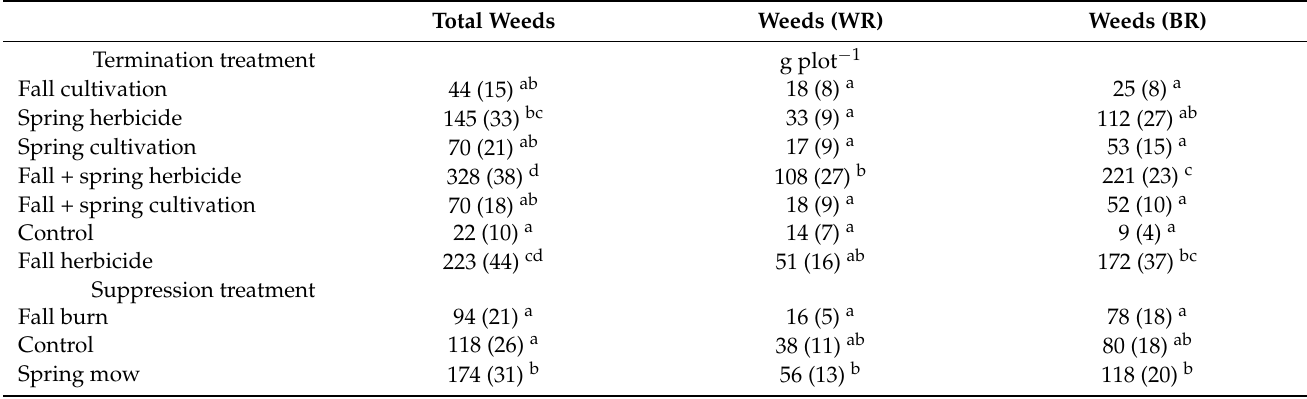
Table 5. Mean ( ± SE) of weed biomass within (WR) and between (BR) planted IWG rows by termina- tion treatments (averaged over suppression treatments) and suppression treatments (averaged over termination treatments) in 2019. Different lower-case letters denote statistical significances between each suppression and termination treatment combination at p <